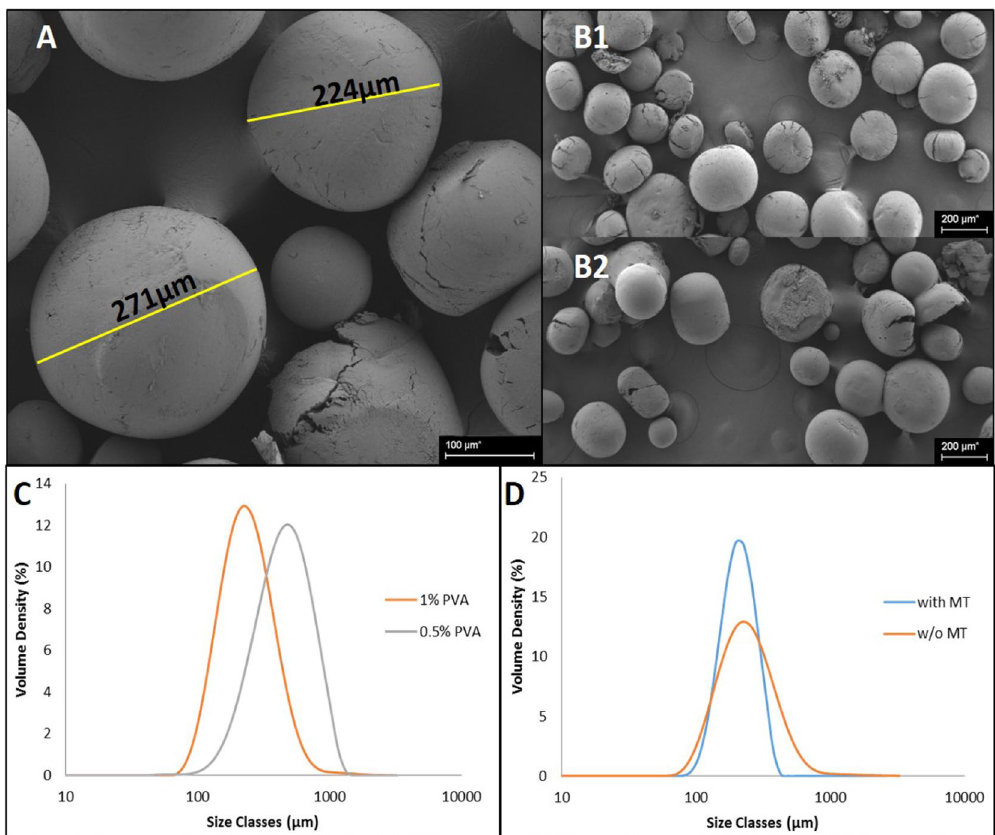
Figure 5. Preliminary experiments with PLGA-PBZ microparticles, with MT clay and without MT clay. SEM images of the PLGA-PBZ microparticles, with ( B2 ) and without clay ( A , B1 ). Mastersizer results showing PLGA-PBZ particle size distribution with two PVA concentrations ( C ). Mastersizer results showing PLGA-PBZ particle size distribution with and without MT clay ( D ).